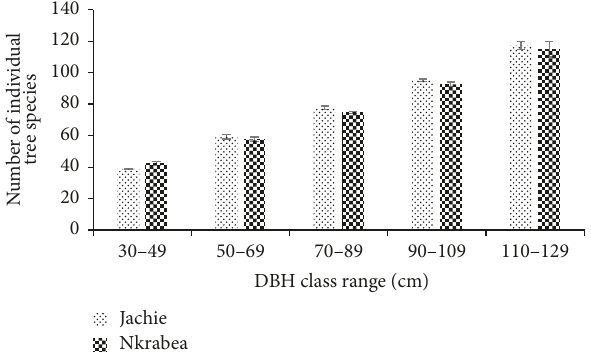
Figure 2: Variations in diameter at breast height among trees in Nkrabea forest reserve and Jachie sacred